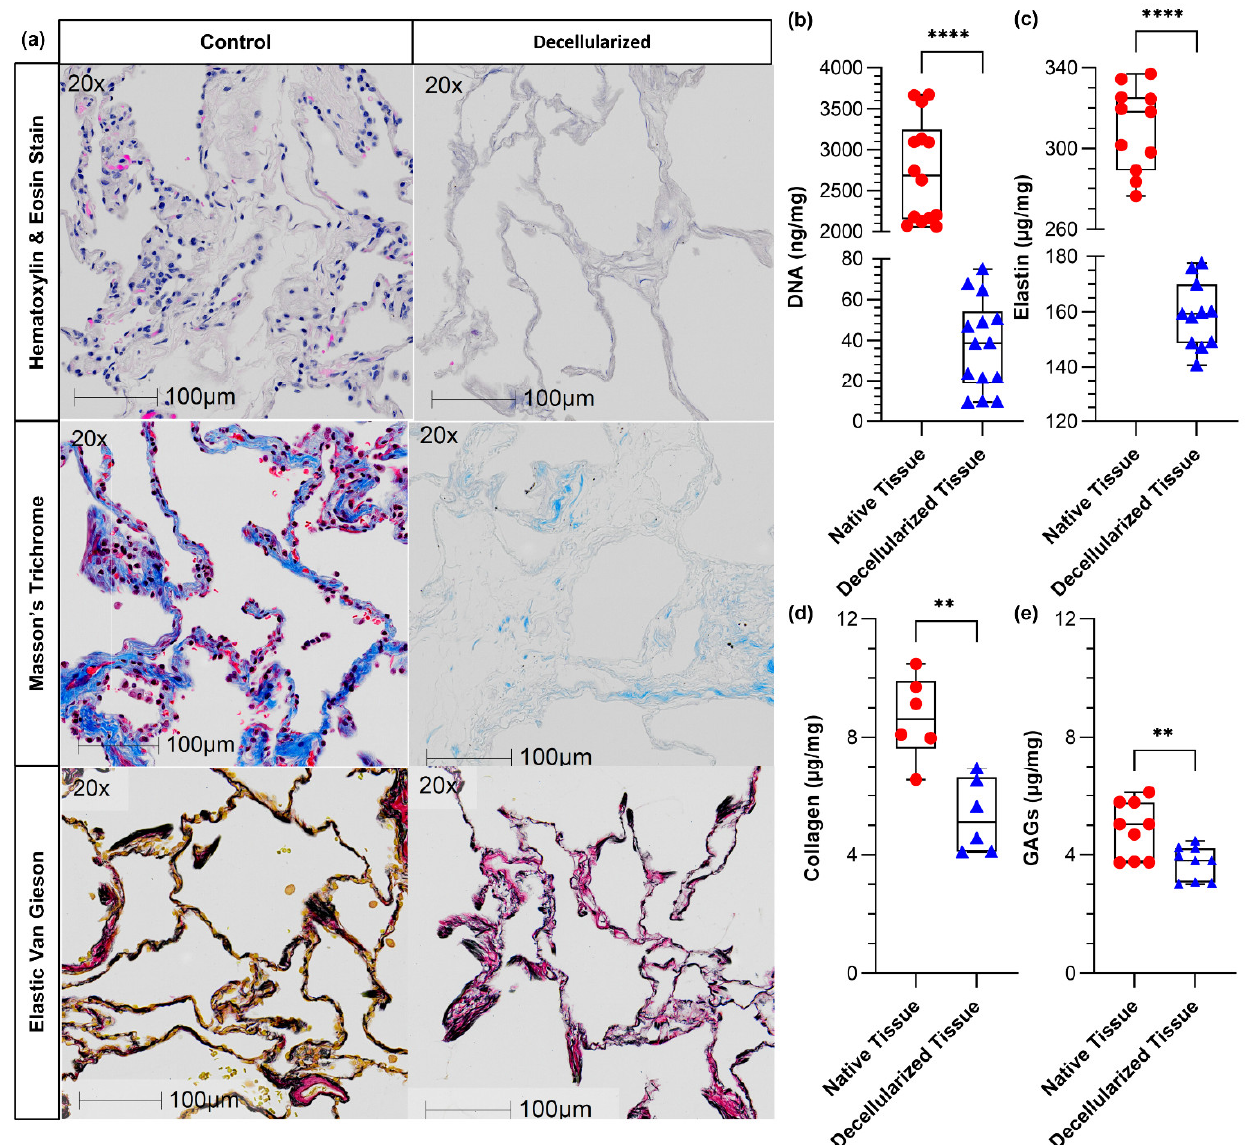
Figure 1. Histologic and biochemical matrix analysis for decellularized human lung tissues: ( a ) hematoxylin and eosin (H&E) images confirmed the removal of the cellular components, ( b ) the quantified double-stranded DNA content using PicoGreen assay before and after decellularization showing that the process was effective, ( c ) the soluble elastin content using The Fastin™ Elastin Assay before and after decellularization, ( d ) the soluble collagen content using The Sircol™ Collagen Assay before and after decellularization, and ( e ) the quantification of soluble GAGs concentration using The Blyscan™ Glycosaminoglycan Assay before and after decellularization. ** p ≤ 0.01 and **** p ≤ 0.0001. n = 14 from 5 individuals, n = 11 from 5 individuals, n = 6 from 3 individuals, and n = 9 from 3 individuals.